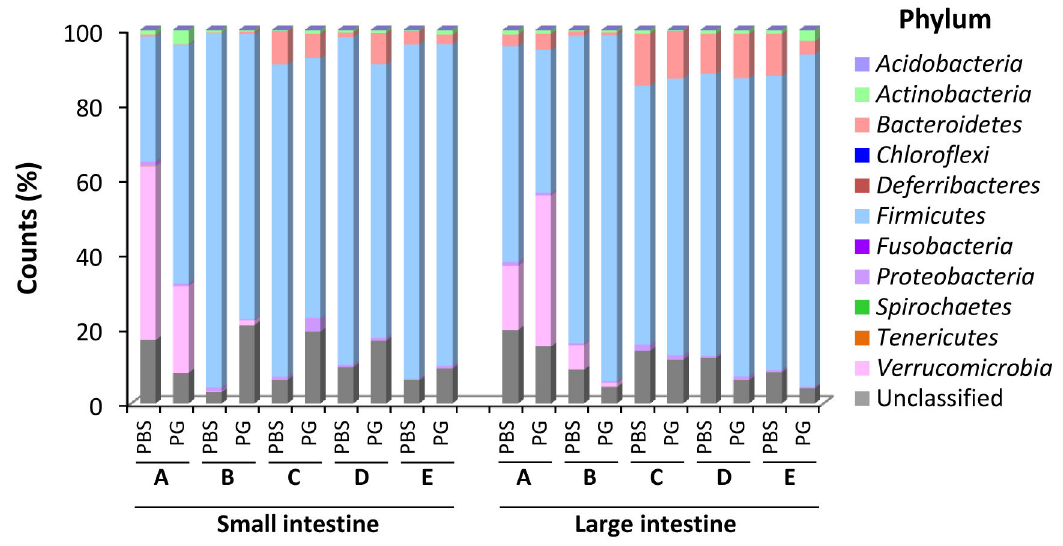
Figure 2. Relative abundance at phylum-level of GIT microbiota in PBS- and PG-administered mice. Relative count of each phylum was calculated from counts of specific phylum and total counts of each sample. Sequences that could not be classified into any known bacterial phyla were assigned as ‘Unclassified’. A, B, C, D and E indicate the results obtained from group A, group B, group C, group D and group E mice,